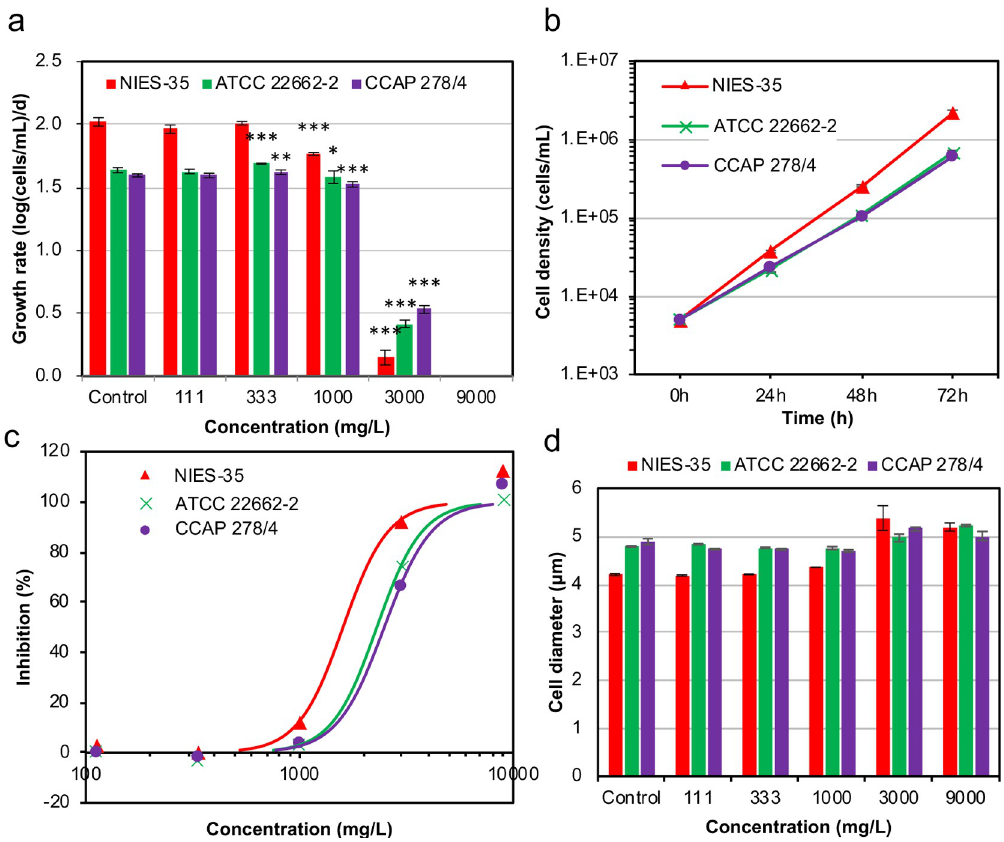
Fig 6. Growth inhibition test of NIES-35, ATCC 22662–2, and CCAP 278/4 with NaCl. (a) Specific growth rate (averaged over 0–24, 24–48, and 48–72 h). ��� p < 0.001; �� p < 0.01; � p < 0.1 vs. control without NaCl. (b) Cell densities in medium without NaCl (Control). (c) Dose-response curves based on the growth inhibition data. (d) Average cell diameter at 72 h after the onset of exposure. Error bars in (a), (b), and (d) denote standard